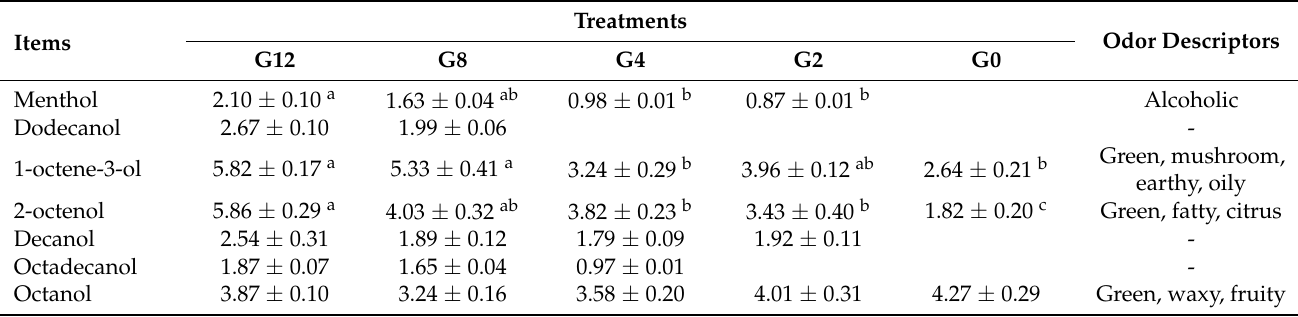
Table 7. Influence of restricted grazing time and indoor supplementary feeding systems on alcohols content of LT muscle in Tan lamb (ng/g).